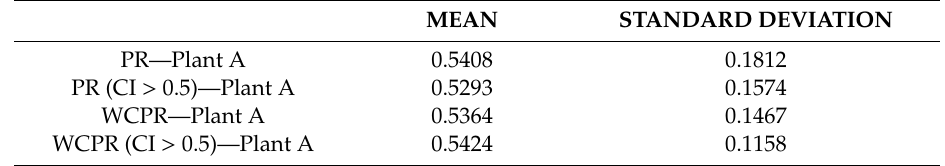
Table 4. Correlation coefficient values of LR, LR (CI > 0.5), WCLR, WCLR (CI > 0.5)—Plant A.